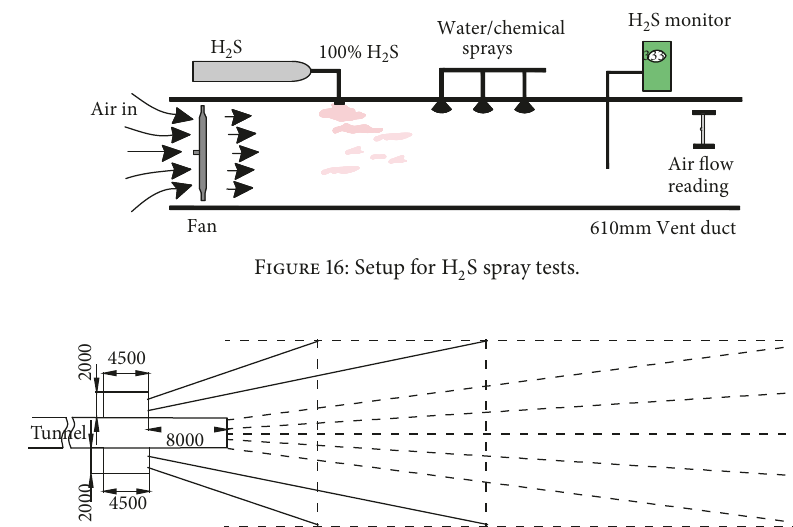
Figure 15: Experimental device for removing hydrogen sulfide gas from wind flow.